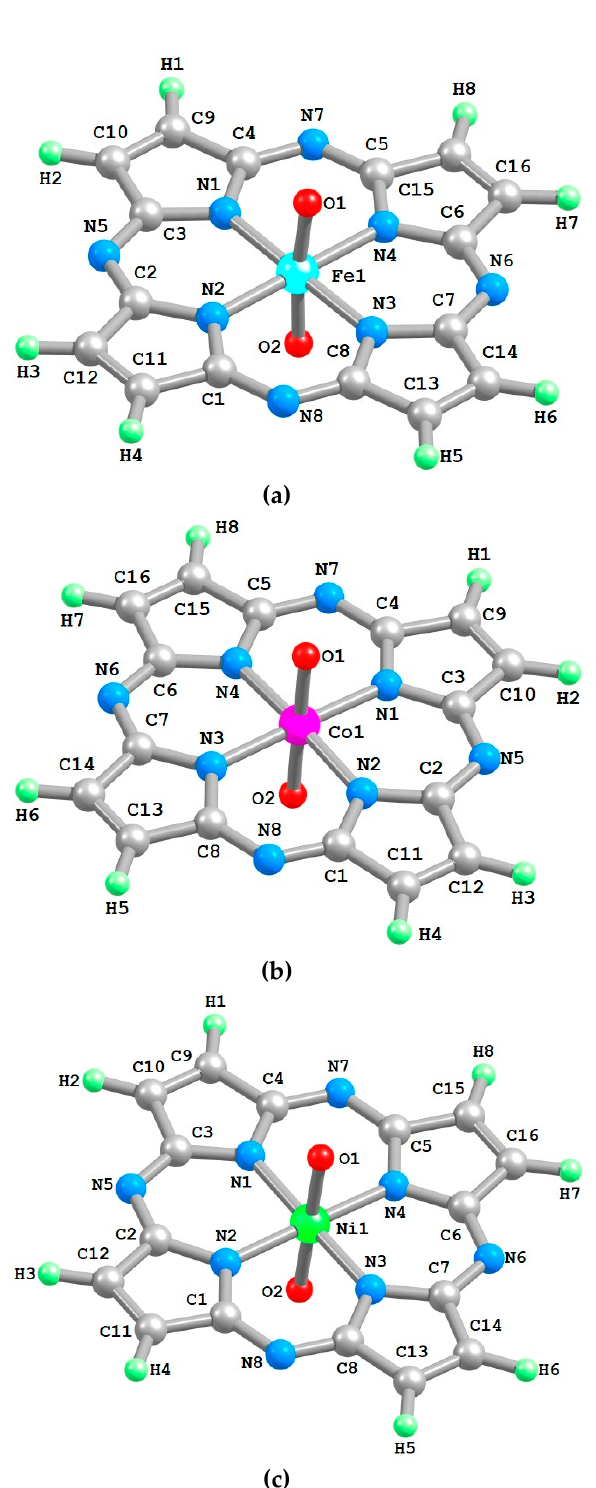
Figure 1. Molecular structures of [M L (O) 2 ] complexes obtained as a result of the density functional theory (DFT) OPBE/TZVP method quantum-chemical calculation : a : Fe(VI), b : Co(VI), c : Ni(VI). The values of the dipole electric moments for this complex, calculated using the DFT OPBE/TZVP method, are 0.14 ([Fe L (O) 2 ), 0.02 ([Co L (O) 2 ) and 0.00 ([Ni L (O) 2 ) Debye units. The standard thermodynamic parameters of formation ( ∆ H 0 f , 298 , S 0 f , 298 and ∆ G 0 f , 298 ) for the given macrocyclic metal chelates under examination are presented in Table